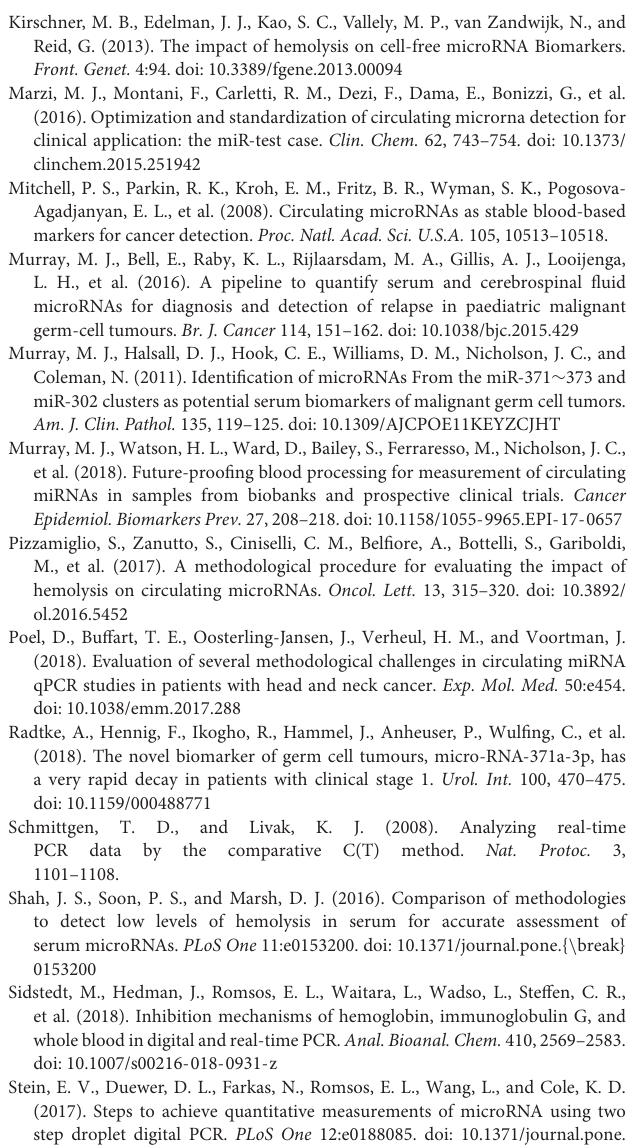
hemolysis condition. TABLE S1 | Mean Cq-values with SD for samples and hemolysis conditions presented in Figures 3 , 4 . DATA FILE S1 | Raw data used for calculations in this